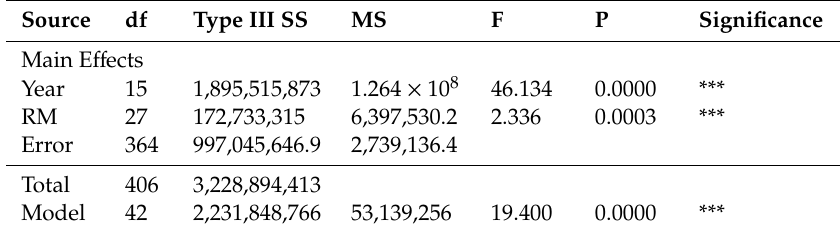
RM = relative maturity, df = degree of freedom, SS = sum of squares, MS = mean square, F = test statistics, P = p value, *** = significant at p value of 0.001.